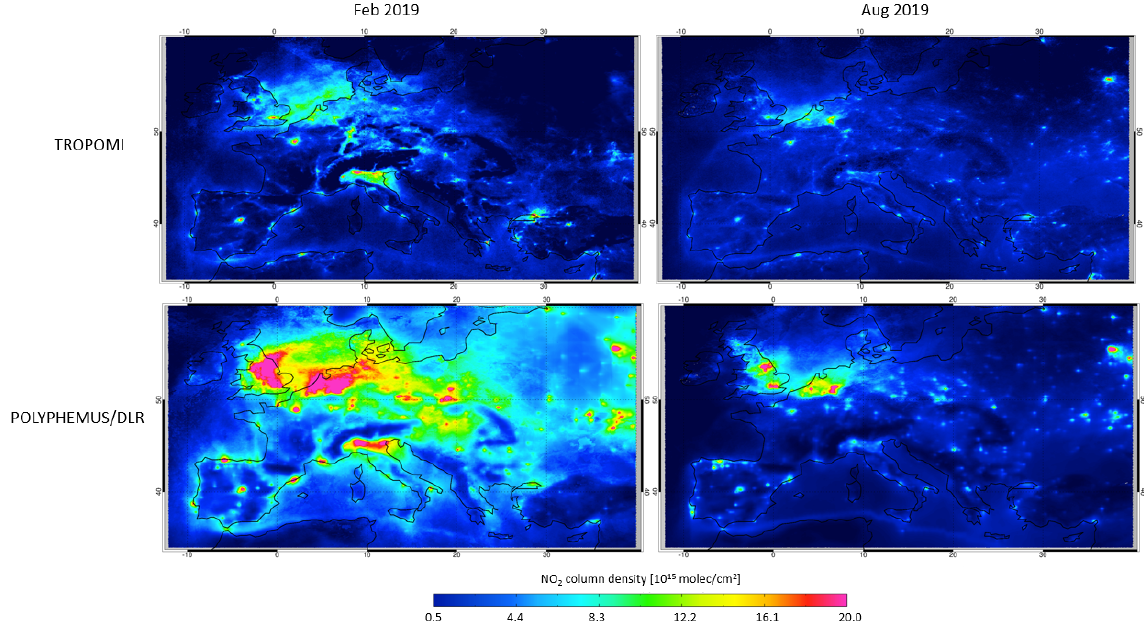
Figure 11. Tropospheric NO 2 columns from TROPOMI measurements (retrieved with the POLYPHEMUS/DLR a priori NO 2 profiles) and POLYPHEMUS/DLR simulations (using the satellite averaging kernel) over Europe in February and August 2019. Only TROPOMI measurements with a cloud radiance fraction less than 0.5 are